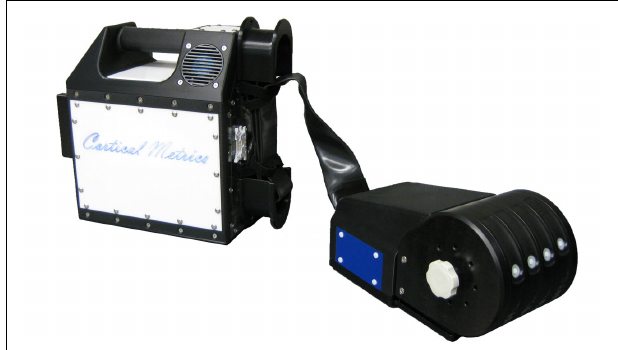
FIGURE 1 | Photo of the multi-site vibrotacitle stimulator. During an experimental session, subject was seated comfortably in a chair with right arm resting on the arm rest attached to the head unit of the stimulator. Vibrotactile stimulation was conducted via 5mm probes that come in touch with subject’s index and middle